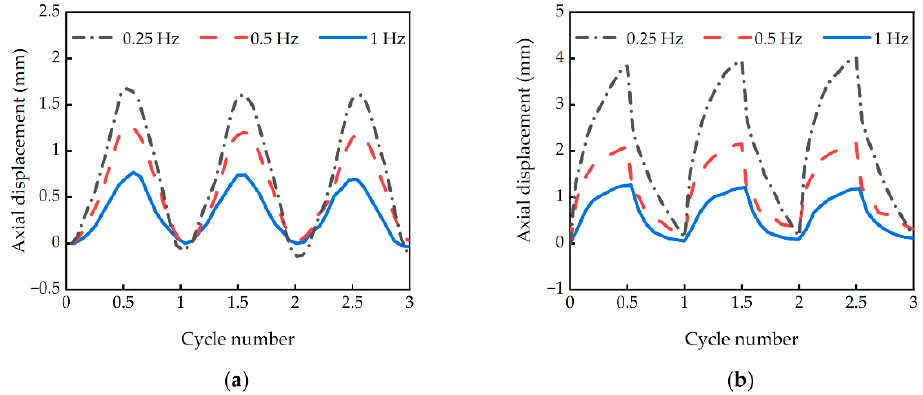
Figure 7. Axial displacements of the helical IPMC actuator under different signals with different frequencies: ( a ) sinusoidal signal; ( b ) square wave signal.